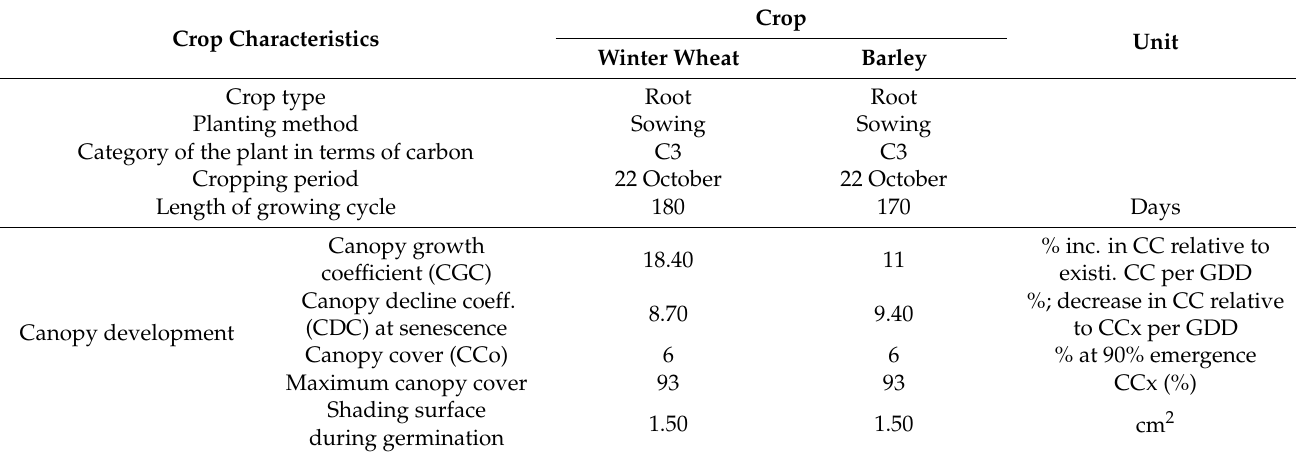
Table 5. Plant parameters used in the model for wheat and barley